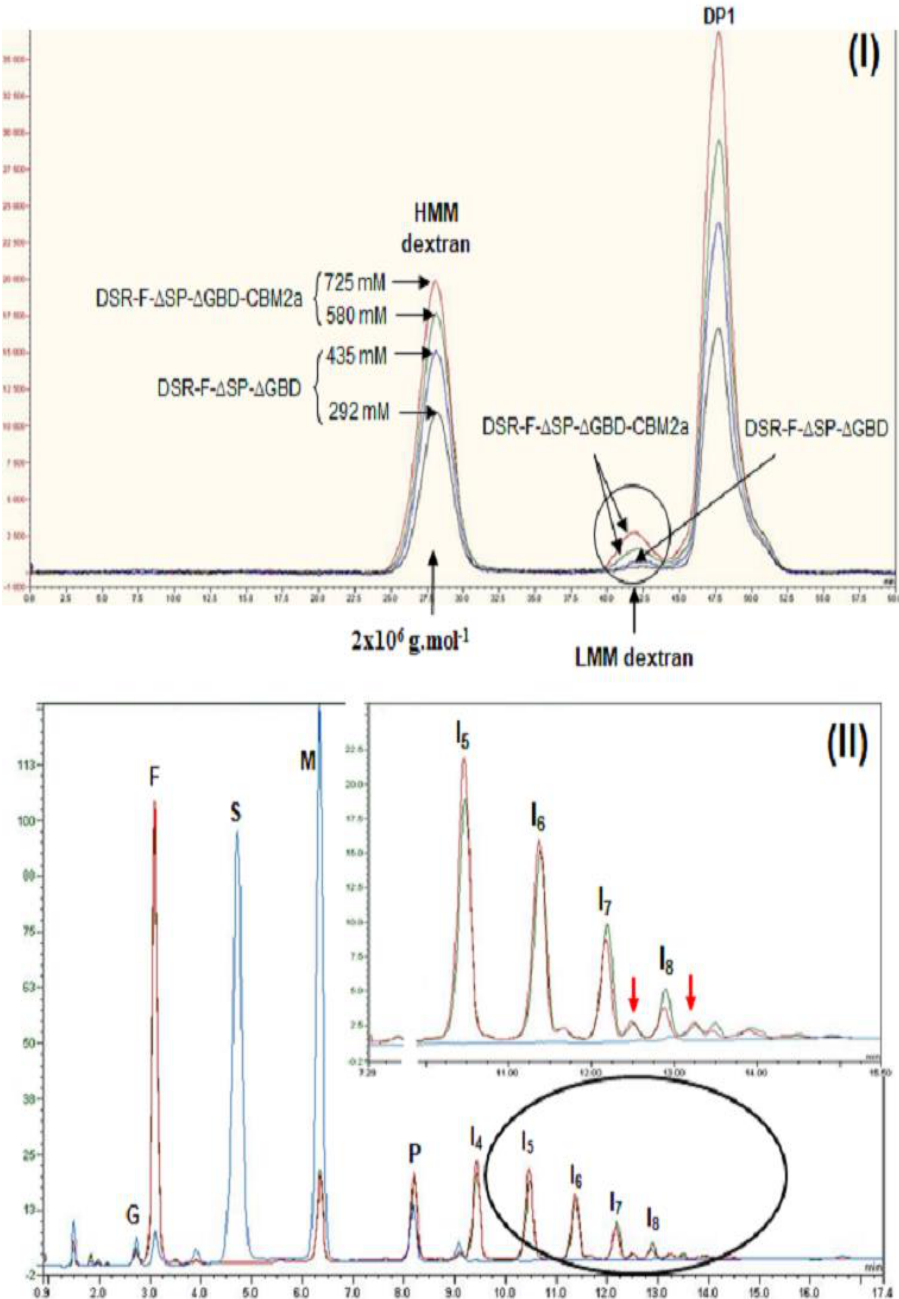
Figure 3. ( I ) Analysis of HPSEC chromatograms synthesized using the chimeric dextransucrase DSR-F-∆SP-∆GBD-CBM2a (from 580 and 725 mM sucrose) and DSR-F-∆SP-∆GBD (from 292 and 435 mM sucrose) with 50 mM sodium acetate buffer, pH 5.5 and 1 U·mL −1 enzyme. Enzymatic reactions were stopped after 24 h. Peak identification: HMM dextran—high-molecular mass dextran (2 × 10 6 g·mol −1 as estimated by HPSEC), LMM dextran—low-molecular mass dextran (oligosaccharides of DP <8), DP1—fructose. ( II ) Analysis of HPAEC-PAD chromatogram products synthesized using DSR-F-∆SP-∆GBD-CBM2a (green line) and DSR-F-∆SP-∆GBD (red line) from sucrose (292 mM) and maltose (146 mM) with 20 mM sodium acetate buffer, pH 5.5 and 1 U·mL −1 enzyme. Enzymatic reactions were stopped after 24 h. Arrows indicate extra peaks after products with degrees of polymerization (DP) of 7 and 8. Peak identification: G—glucose, F—fructose, S—sucrose, M—maltose, P—panose (DP3), I4–I8—isomaltooligosaccharides of DP4–DP8. The line with the highest signal of S and M and no detection of isomaltooligosaccharides corresponds to the initial reaction time (t = 0 min, blue